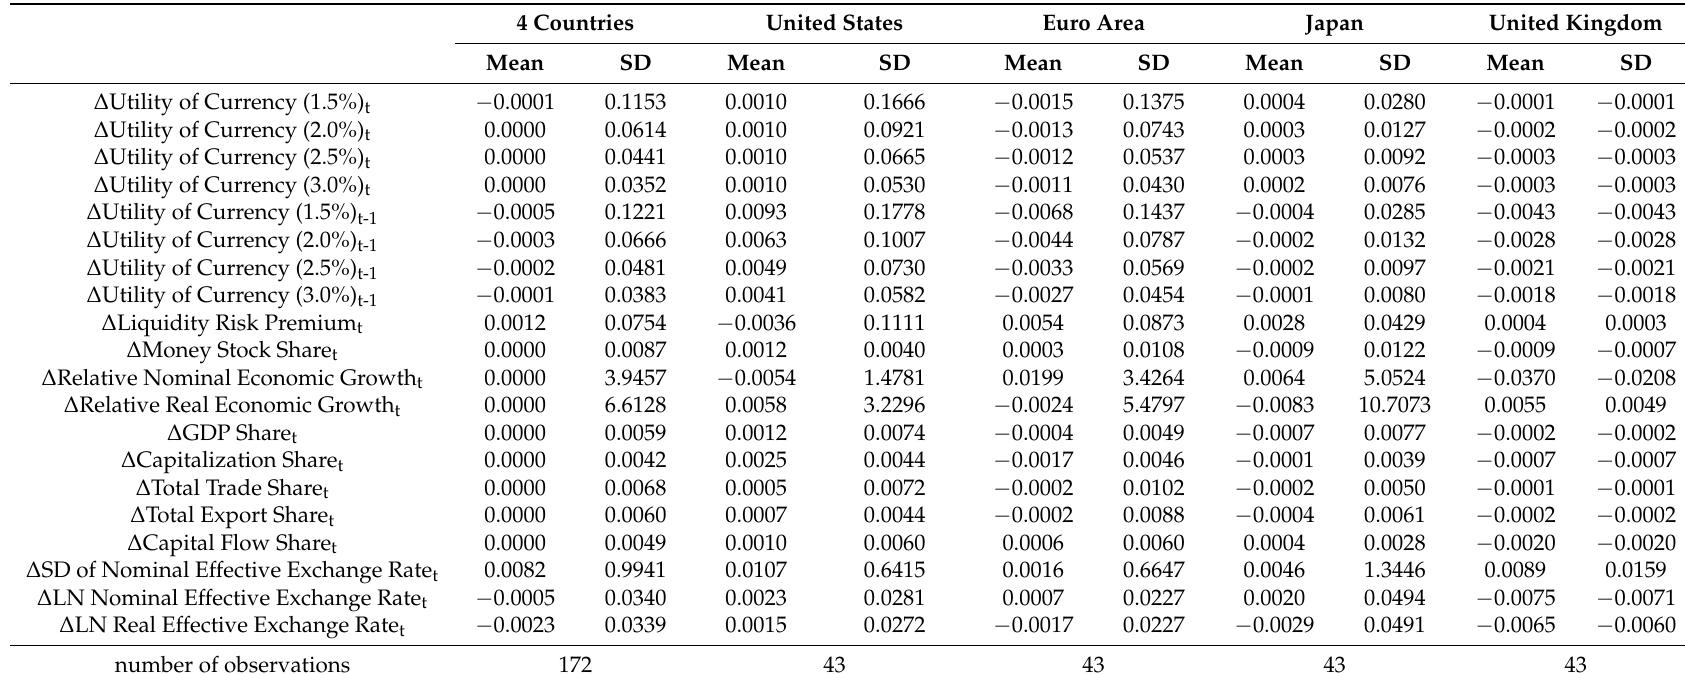
Table 1. Descriptive Statistics of difference of each